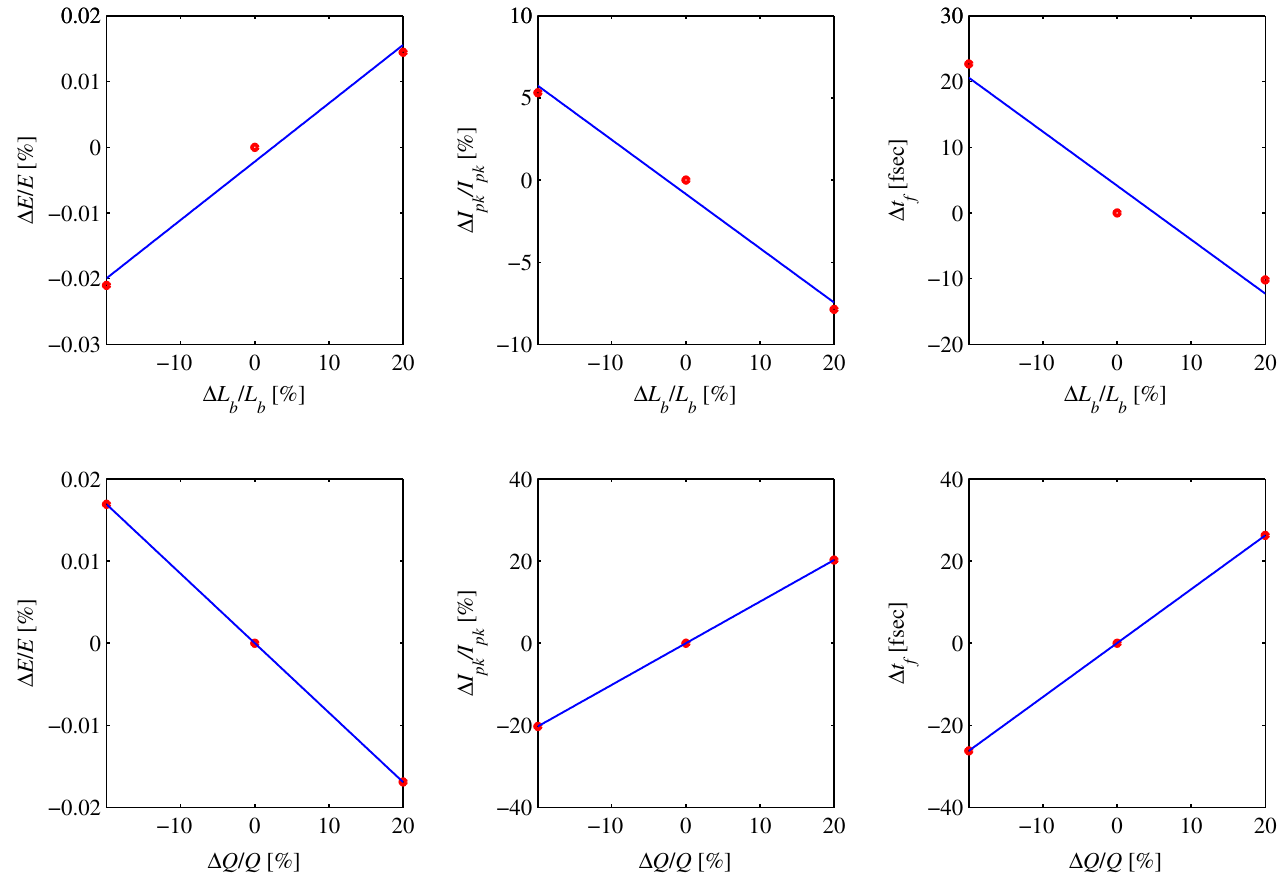
FIG. 10. (Color) Relative mean energy (cid:1) E=E , relative peak current (cid:1) I pk =I pk , and bunch arrival time variation (cid:1) t f as a function of the relative initial bunch length variations (cid:1) L b =L b (upper plots) and relative initial bunch charge variations (cid:1) Q=Q (lower plots).